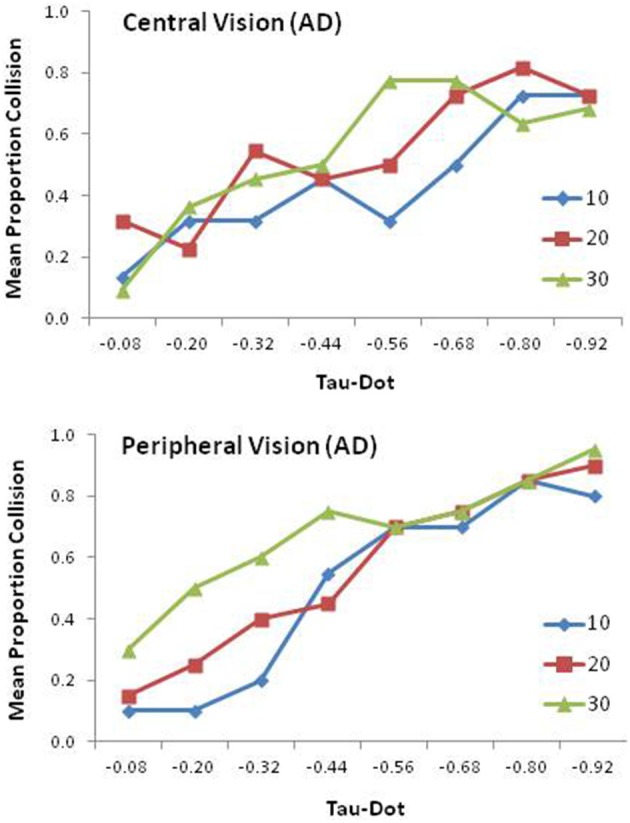
Mean proportion of collision responses for AD patients as a function of tau-dot and mask size in the central (top panel) and peripheral (bottom panel) vision conditions.